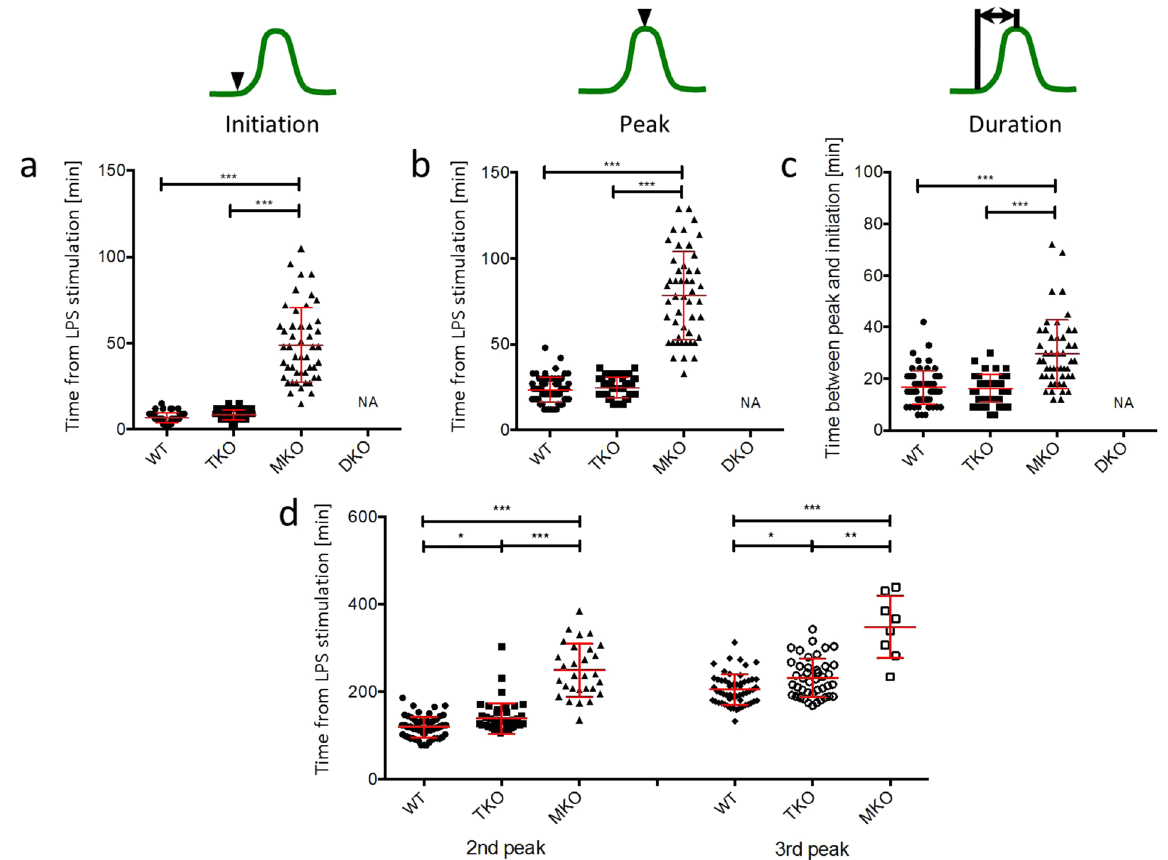
Figure 2. Timings of LPS-induced NF- κ B nuclear translocation in TRIF-deficient macrophages are similar to those in wild-type macrophages. Population distributions of initiation timing ( a ), peak timing ( b ), and duration between initiation and peak timing ( c ) of the first peak in NF- κ B nuclear translocation dynamics in the iBMDM reporter. Each dot shows a single cell from four independent experiments for each cell line. The bars show mean value ± s.d. ( d ) Peak timings of the second and third peaks in NF- κ B nuclear translocation dynamics. *** P < 0.0001, ** P < 0.01, * P < 0.05, one-way ANOVA with Kruskal-Wallis